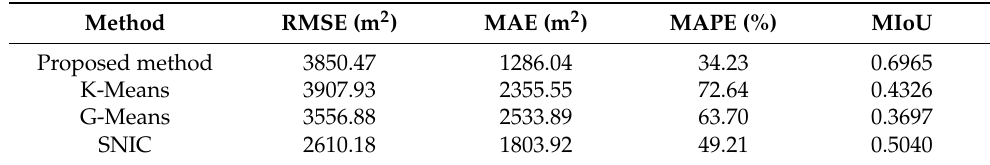
Table 5. Overall segmentation accuracy comparison between the proposed, K-Means, G-Means, and SNIC